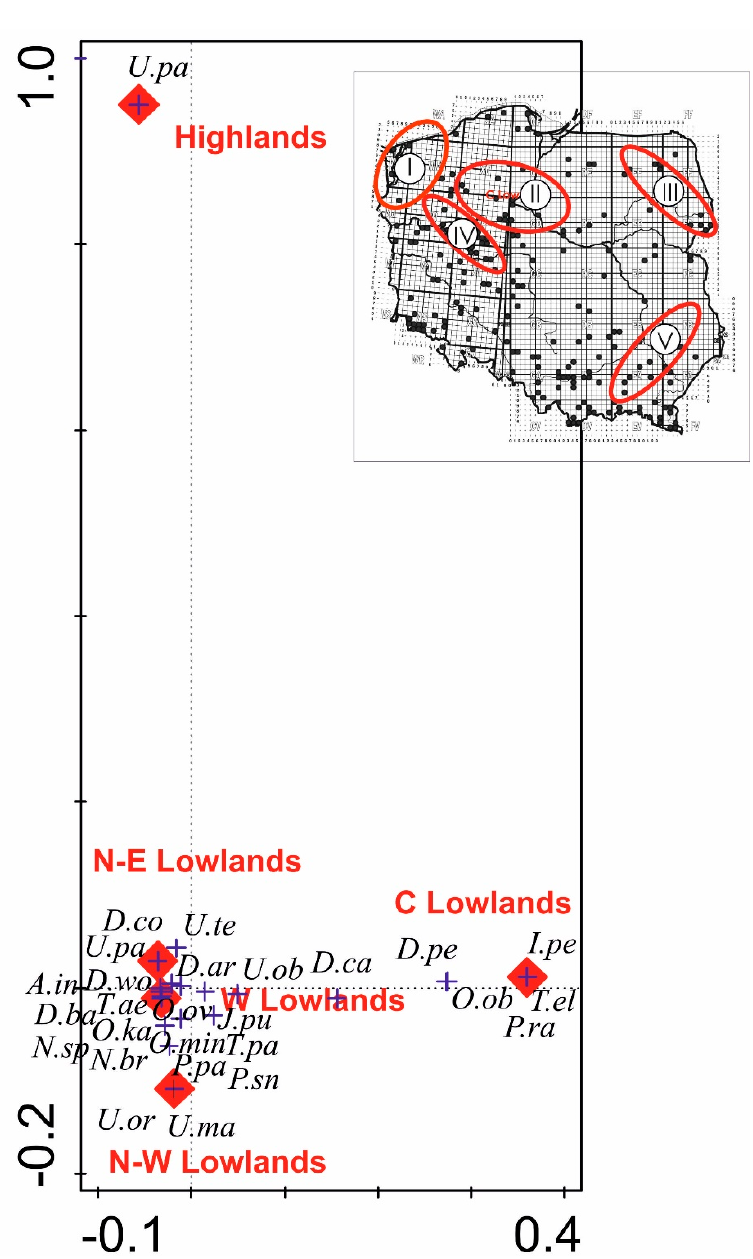
Figure A4. Canonical Correspondence Analysis (CCA) scatterplot showing the relationships be- tween examined Uropodina mite communities from Scots pine from different regions of Poland from 17 samples from NE lowlands (Podlachia+Warmia) (III), 16 from central lowlands (Kuyavia) (II), 7 from north-western lowlands (I) and 4 from highlands (V) and 132 from western lowlands (Greater Poland) (IV) on the first two axes. First and second axis explained 3.63% of variation (pseudo-F = 2.2, p = 0.028). Abbreviations of species are included in Section 2.